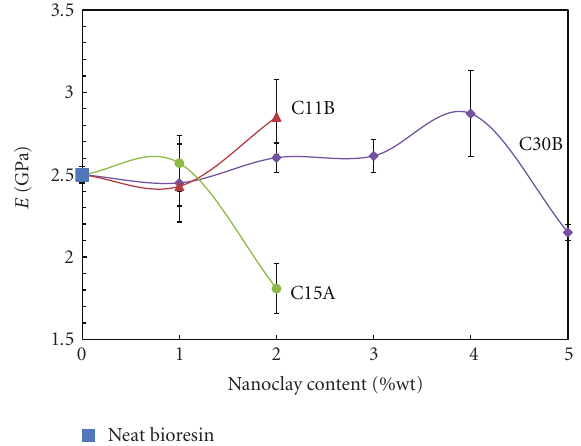
Figure 8: Flexural modulus of nanoclays reinforced polyester bioresin (matrix